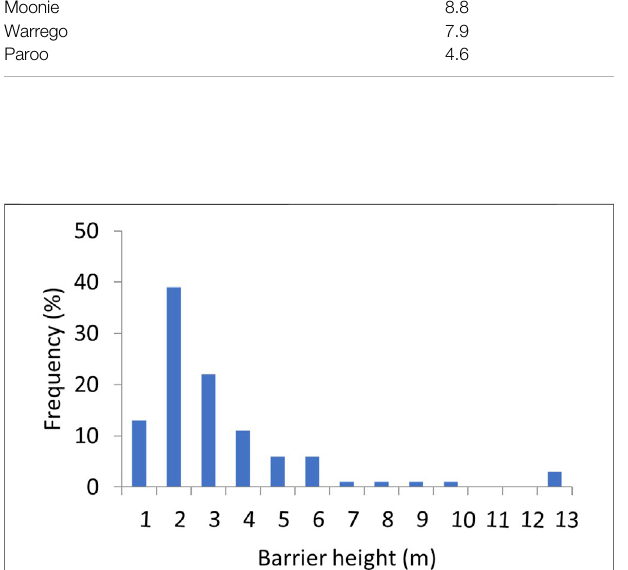
FIGURE4| Frequencyhistogramoftheheightofinstreambarriersinthe QMDB with height bins of 1 m.